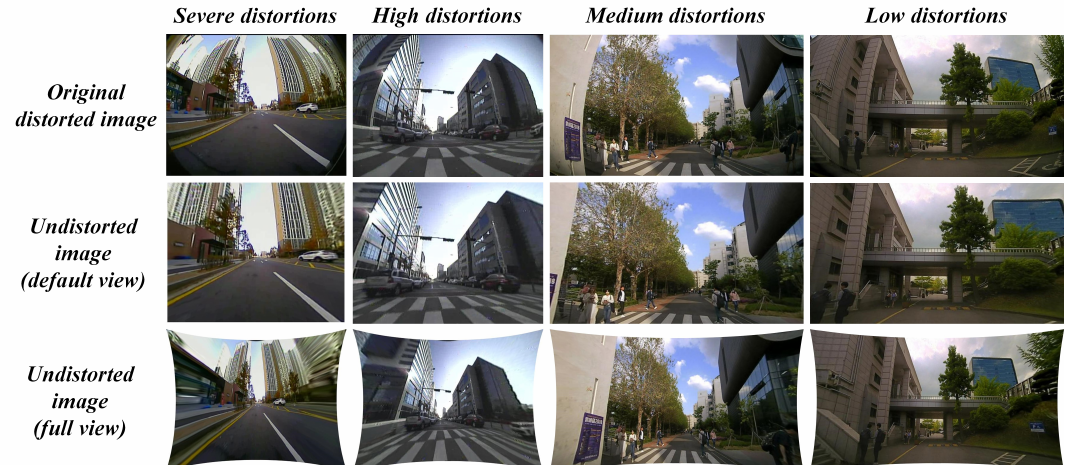
Figure 9. Distortion rectification of severe, high, medium, and low level of distortions using the proposed